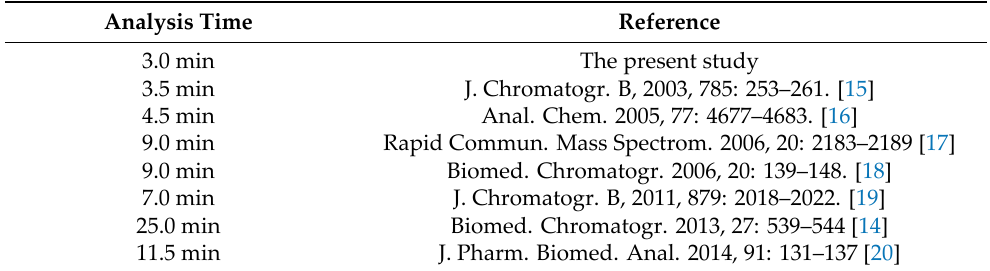
Table 1. The analysis time per run comparison between the present study and the reported publications.